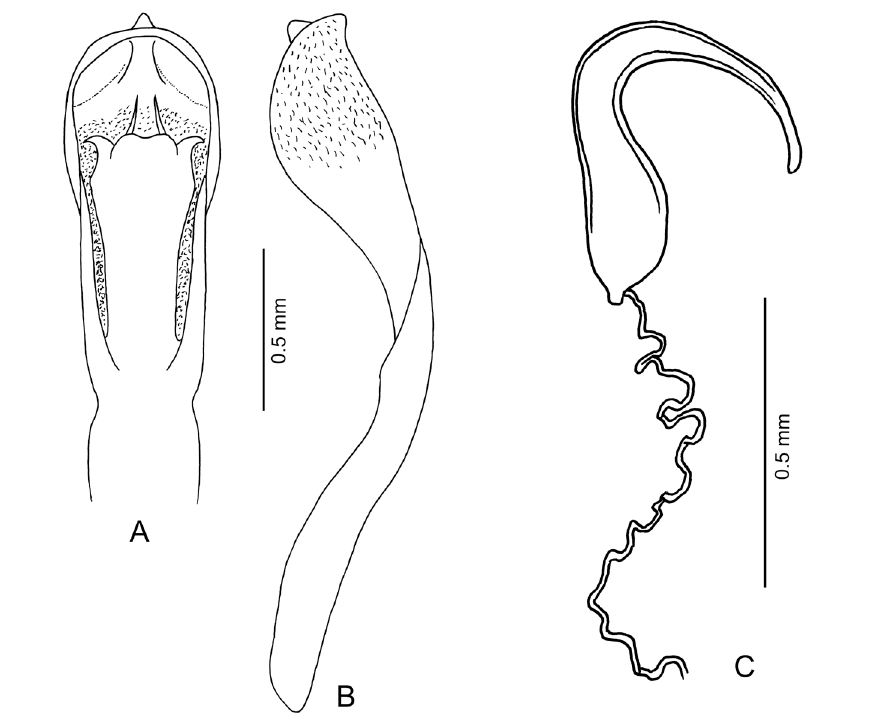
Fig. 5. Melitonoma decemnotata (Thunberg, 1787) comb. nov. A . Aedeagus, dorsal view. B . Aedeagus, lateral view. C .